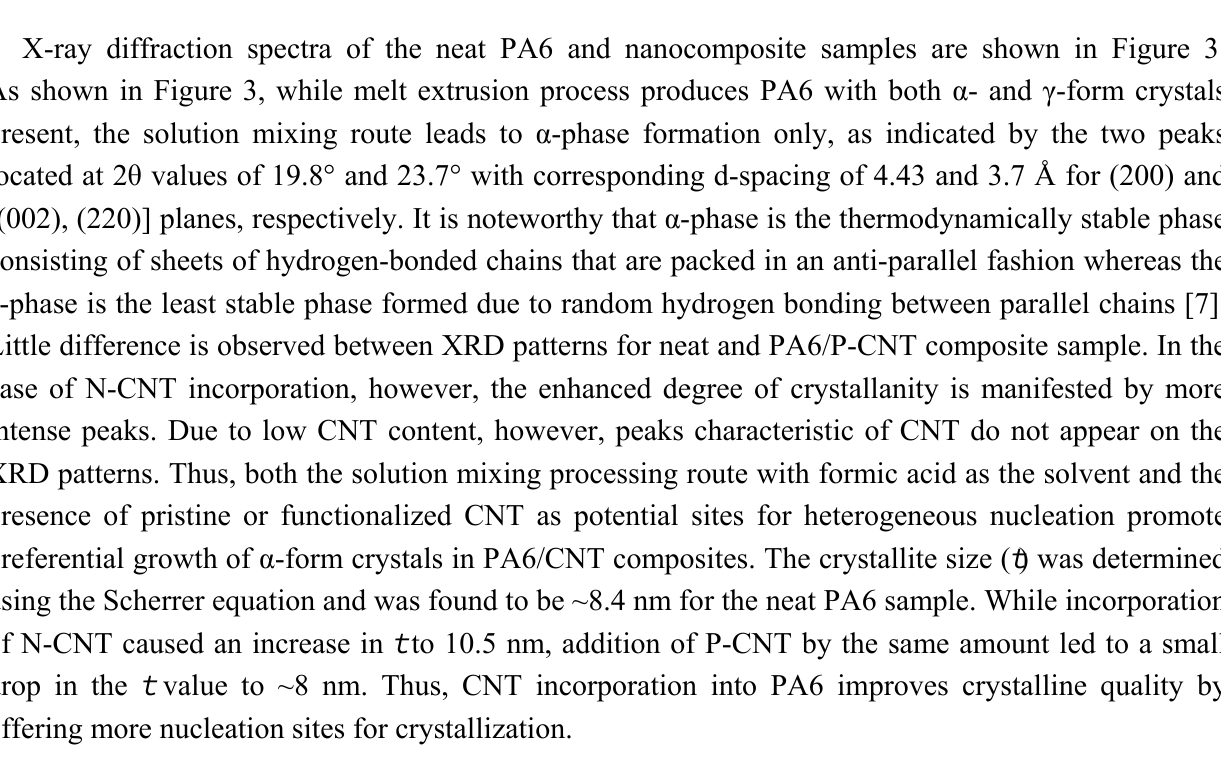
Figure 3. X-ray diffraction patterns of neat PA6 (both from solution mixing and melt extrusion) and PA6/CNT